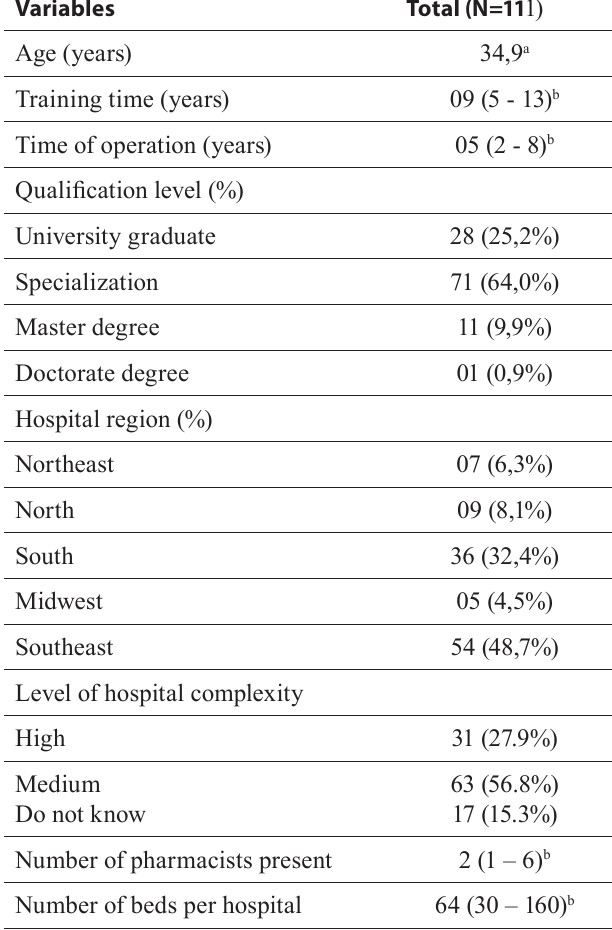
Table I - C haracterization of pharmacists and